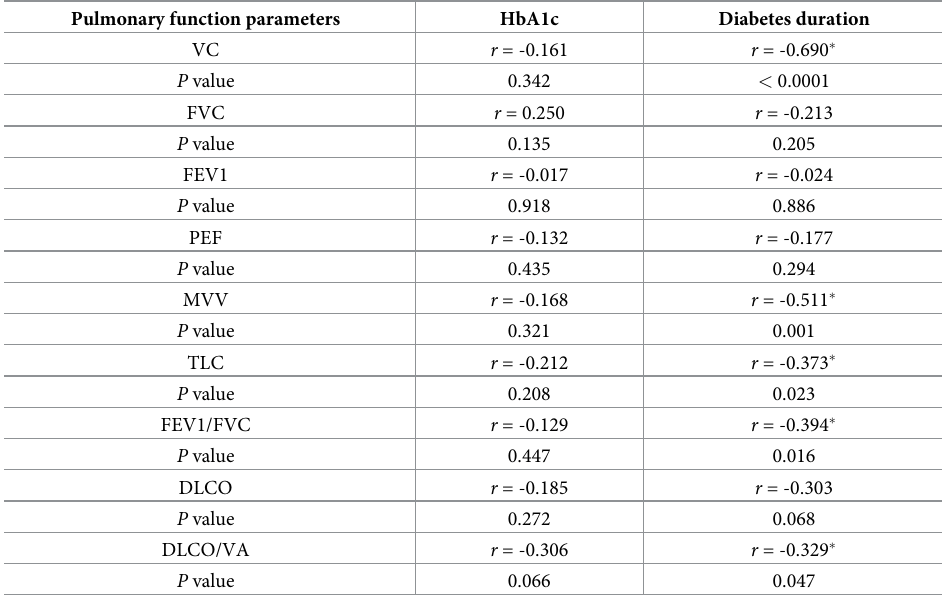
Table 2. Correlation of pulmonary function parameters to HbA1c and diabetes duration in diabetes group. Pulmonary function